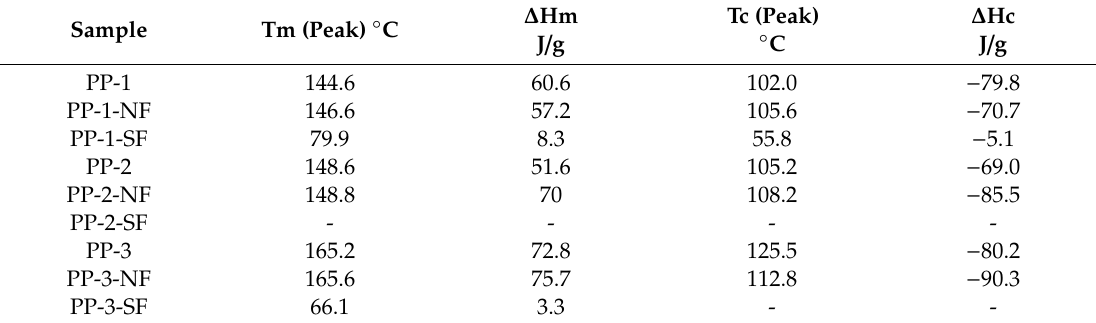
Table 6. DSC analysis results *d .